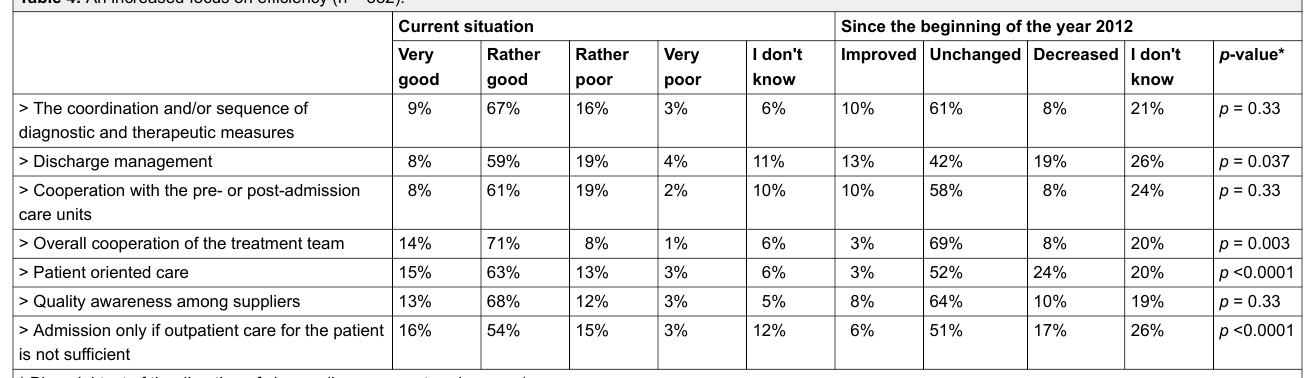
Table 4: An increased focus on efficiency (n =